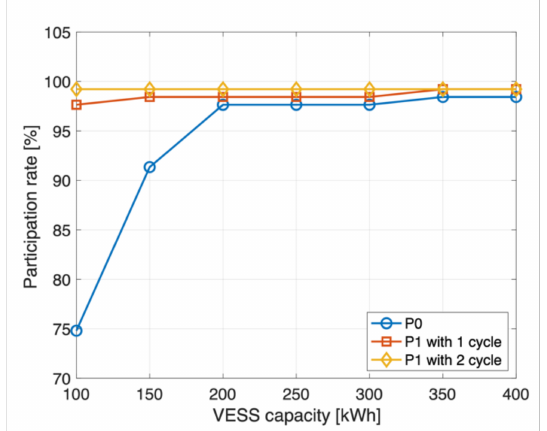
Figure 6. Percentage of participants using the VESS service. The participant rate is measured as the number of units who participant the VESS service among all SEC units, i.e., 127 units.